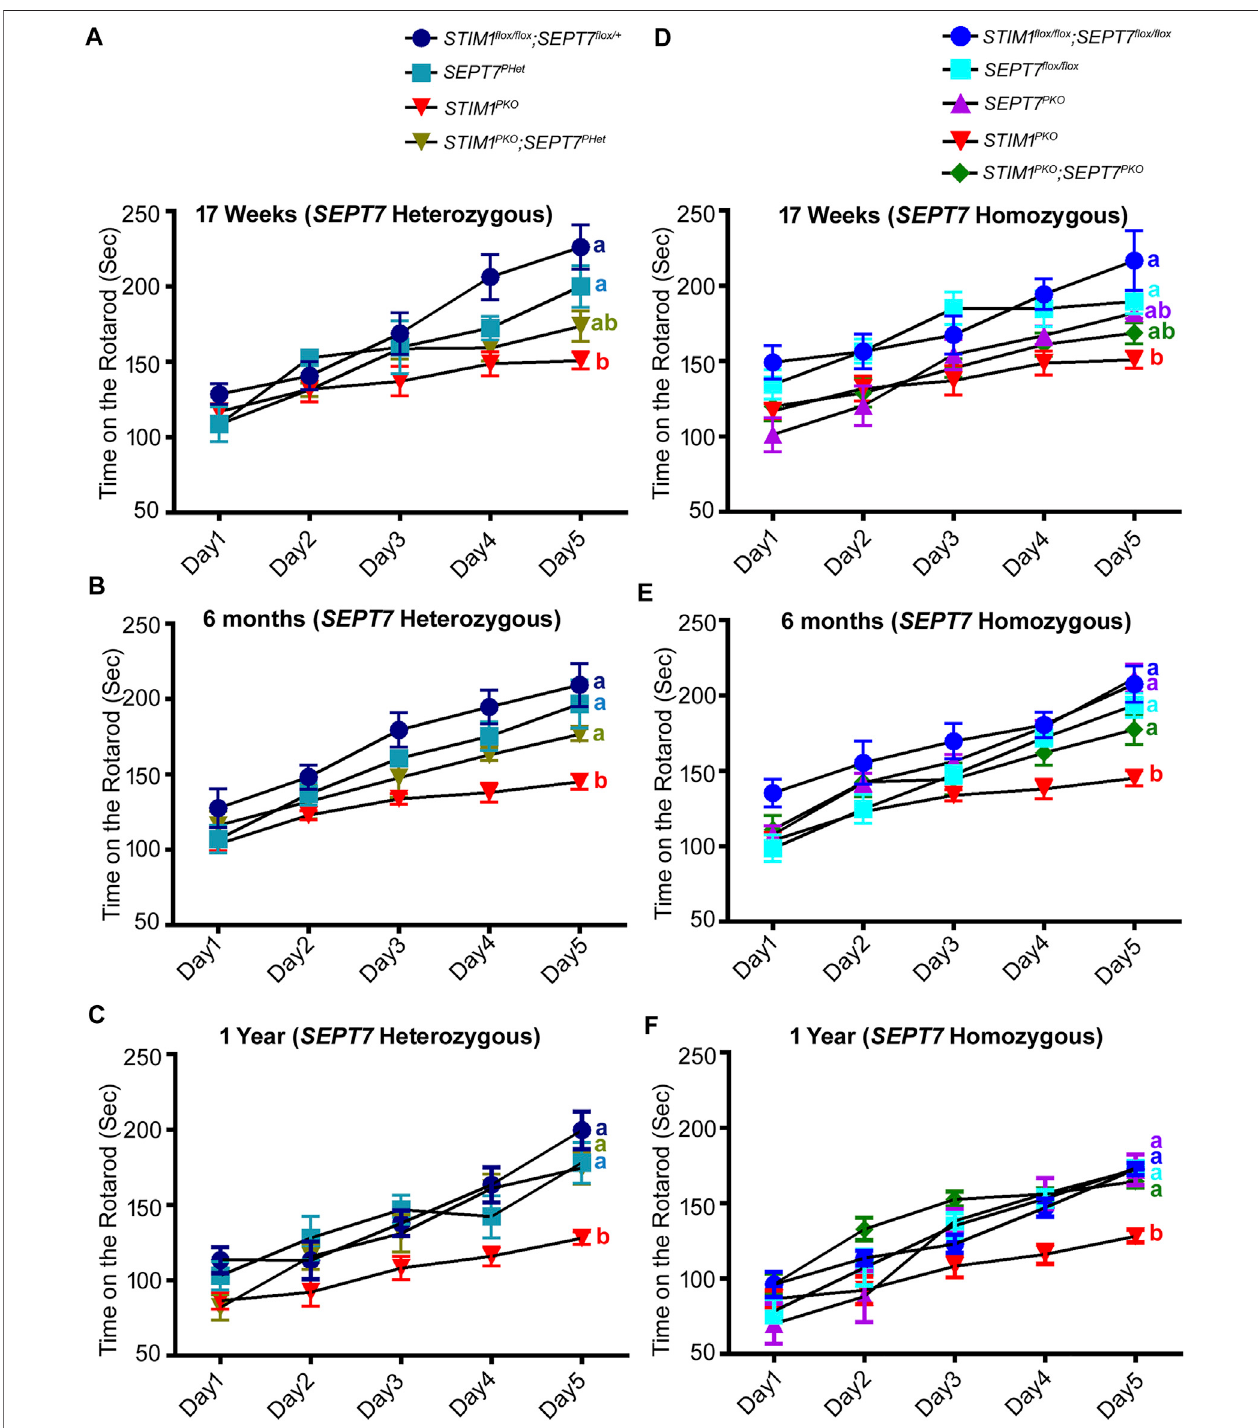
FIGURE 5 | Reduction and loss of SEPT7 rescue loss of motor learning and coordination arising from loss of STIM1 in Purkinje neurons mean latency times on the rotarod are shown for the indicated genotypes at (A, D) 17 weeks, (B, E) 6 months, and (C, F) 1 year of age. The number of mice tested for each genotypes is STIM1 fl ox/ fl ox ; SEPT7 fl ox/+ ( n (cid:1) 6), SEPT7 PHet ( n (cid:1) 4), STIM1 PKO ( n (cid:1) 7), STIM1 PKO ; SEPT7 PHet ( n (cid:1) 5), STIM1 fl ox/ fl ox ; SEPT7 fl ox/ fl ox ( n (cid:1) 6), SEPT7 fl ox/ fl ox ( n (cid:1) 8), SEPT7 PKO ( n (cid:1) 6), STIM1 PKO ( n (cid:1) 7), STIM1 PKO ; SEPT7 PKO ( n (cid:1) 8). Same alphabets at the end of line plots represent statistically indistinguishable groups, the color of the alphabetsdenotestherespectivelineplots,anddifferentalphabetsrepresent p < 0.05.Two-wayANOVA,aposthoctest,followedbyTukey ’ smultiplecomparisonstest were